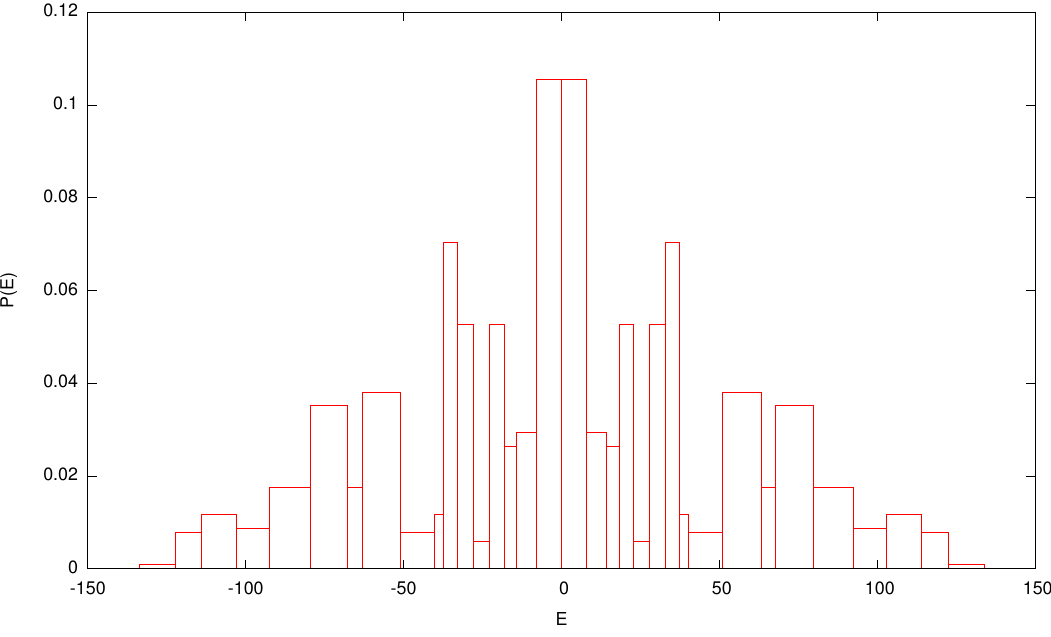
Figure 2 . The density of states vs the energy levels. The spectrum has spectral mirror symmetry i.e., the spectrum is symmetric around E = 0.